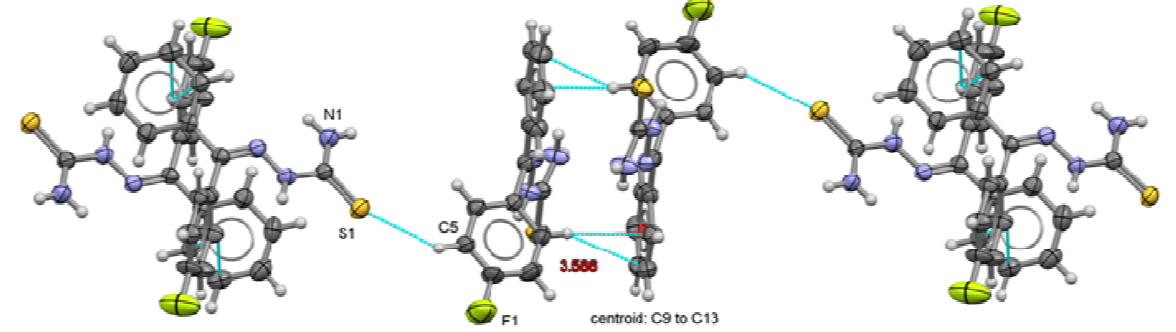
Figure 12. Packing arrangement of 4-C interactions between thiophenolate